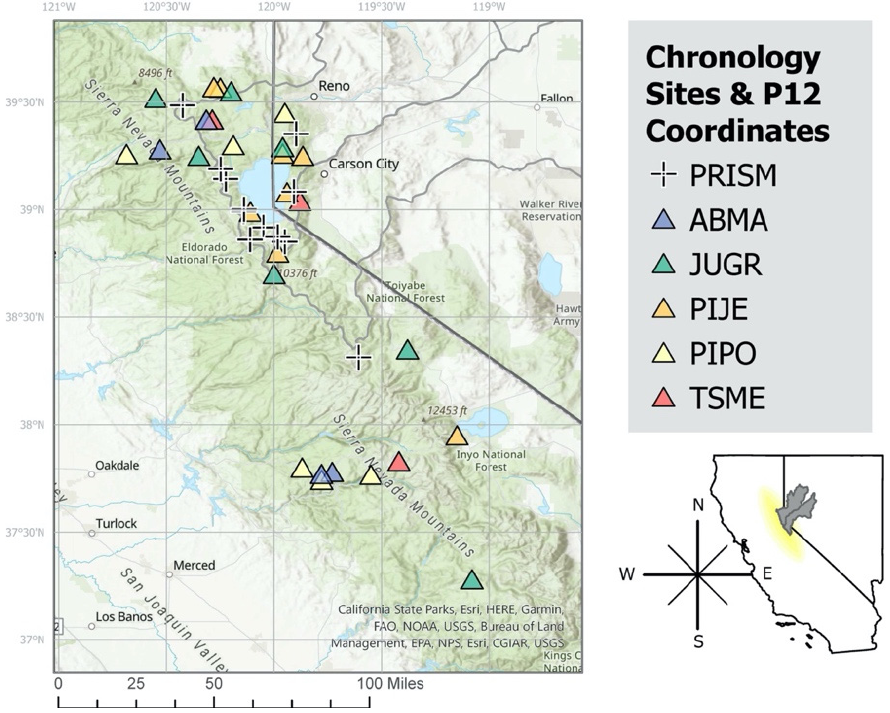
Figure 1. Regional map showing chronology sites color-coded by species and PRISM grid point locations used for regional water-year precipitation interpolation.